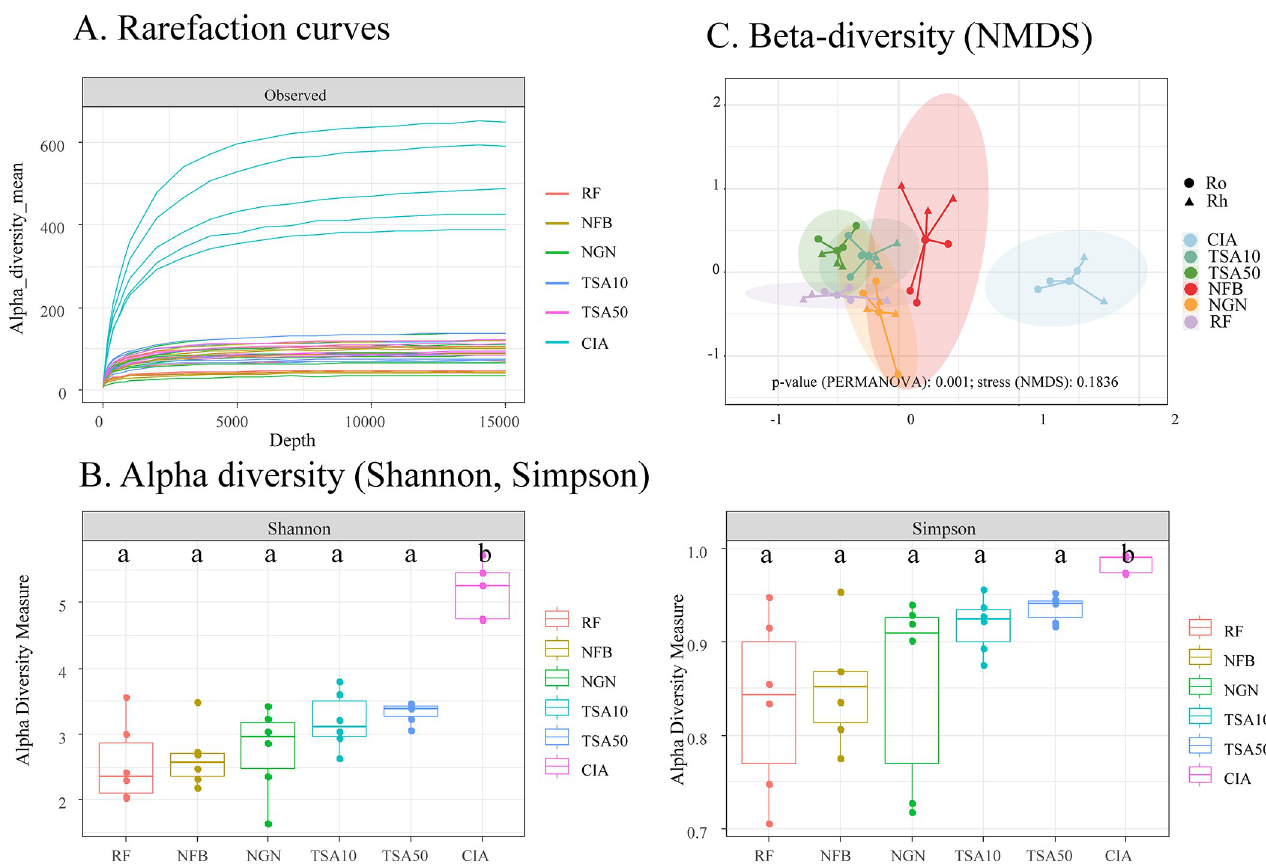
Fig 2. Rarefaction curves (A), alpha (B) and beta diversity (C) in 16S amplicon libraries. Alpha diversity (A) rarefaction curves were calculated on unfiltered data, while alpha diversity indices (B) were calculated using the Shannon and Simpson index. Letters above boxplots indicate statistical significance using a pairwise Wilcoxon test (adjusted with the Bonferroni method). The p-value of a PERMANOVA test on beta diversity is indicated at the bottom of (C). Coloured circles on the NDMS are ellipses of confidence (at 95%) for all media and CIA conditions. Abbreviations: CIA: culture-independent approach; media used in the CDA: RF: rice flour, NFB: nitrogen-free medium, NGN: Norris glucose N-free medium, TSA10 and TSA50: tryptone soya agar at 10 and